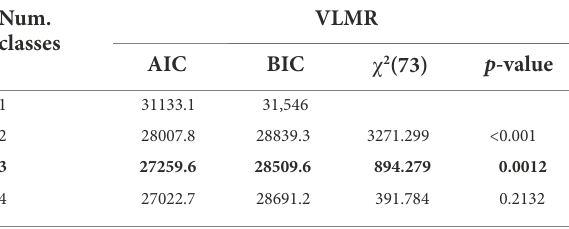
TABLE 2 Fit statistics for classes with different numbers of